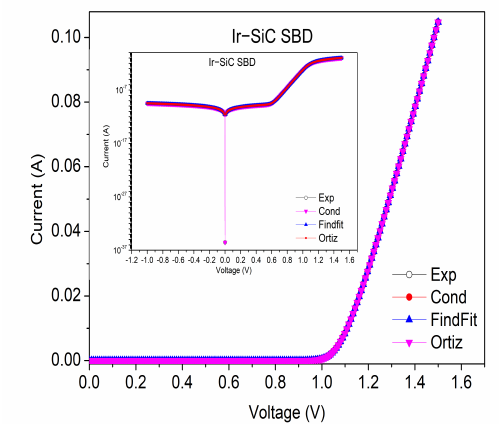
Figure 1. Experimental data and numerical characteristics obtained via the three methods for the Ir-SiC-based SBD. The inset figure shows the semi-log scale for these characteristics.